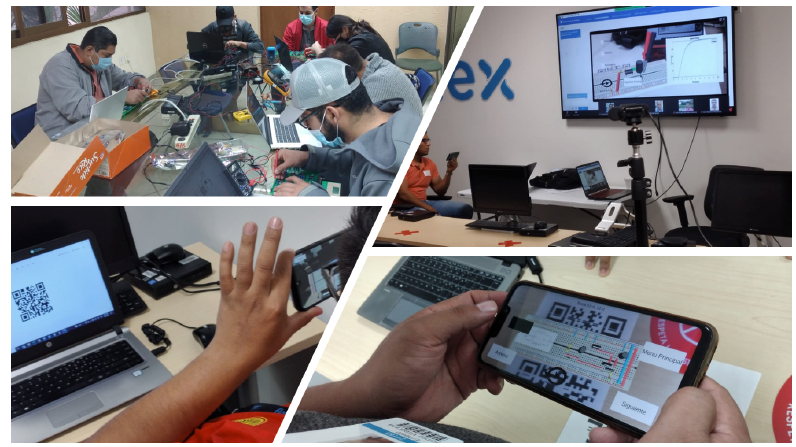
Figure 10. Using the AR-electronics app. Table 2. List of features and services on offer of the AR-electronics app.